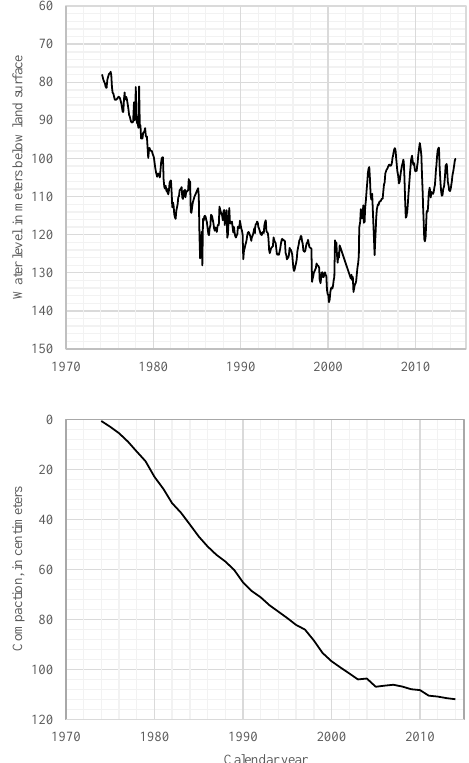
Figure 3. Observed change in ellipsoidal height calculated (Zilkoski et al., 2003) at GPS monitoring stations from 2010 to 2014, Houston area, Texas. Figure 4. Water-level and cumulative compaction at the Addicks extensometer located in Harris Galveston Subsidence District Reg- ulatory Area 3, Houston, Texas, USA,